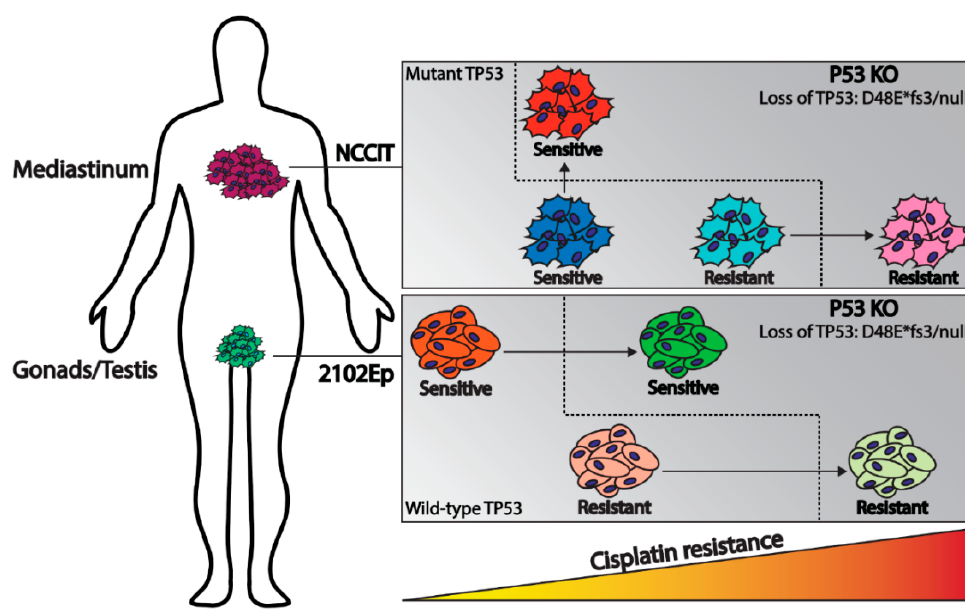
Figure 5. Schematic overview illustrating the model of this study. Mediastinal GCTs (NCCIT cell line) have a bias towards TP53 mutations where testicular GCTs (2102Ep cell line) usually harbor wild-type TP53 . In both cases knock-out of TP53 results in increased cisplatin resistance. Supplementary Materials: The following are available online at https://www.mdpi.com/article/10.3390/ijms222111774/s1.